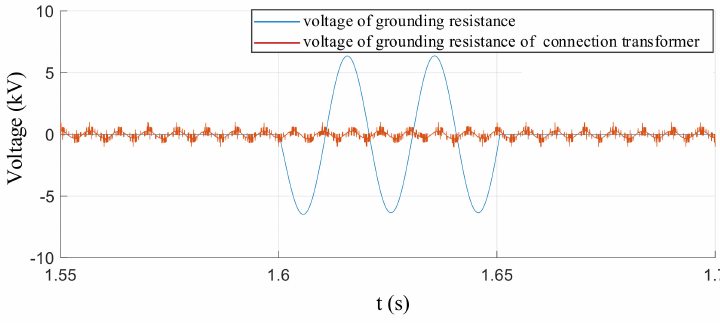
Figure 6. Voltage waveform across the neutral point grounding